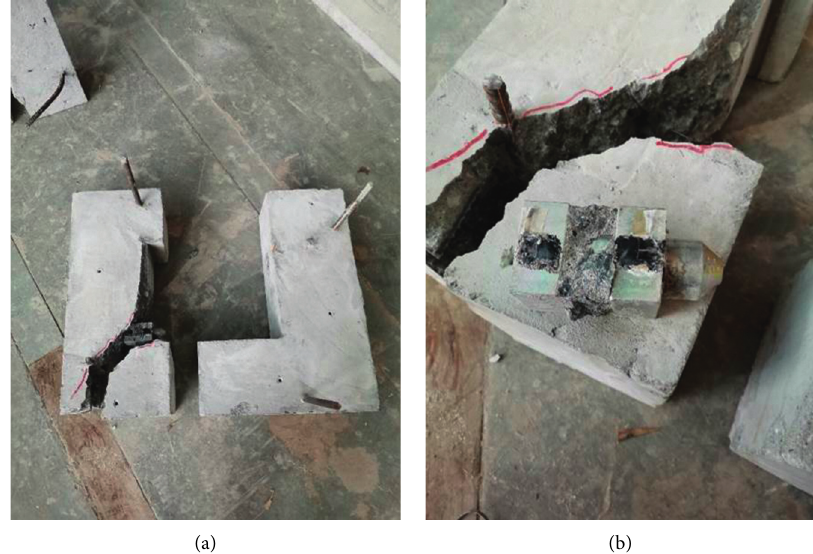
Figure 11: Failure mode of